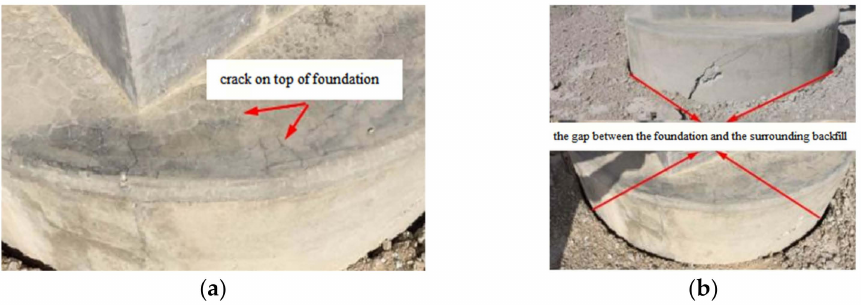
Figure 1. Crack in the foundation part of Tower 292: ( a ) crack on top of foundation; ( b ) the gap between the foundation and the surrounding backfill.